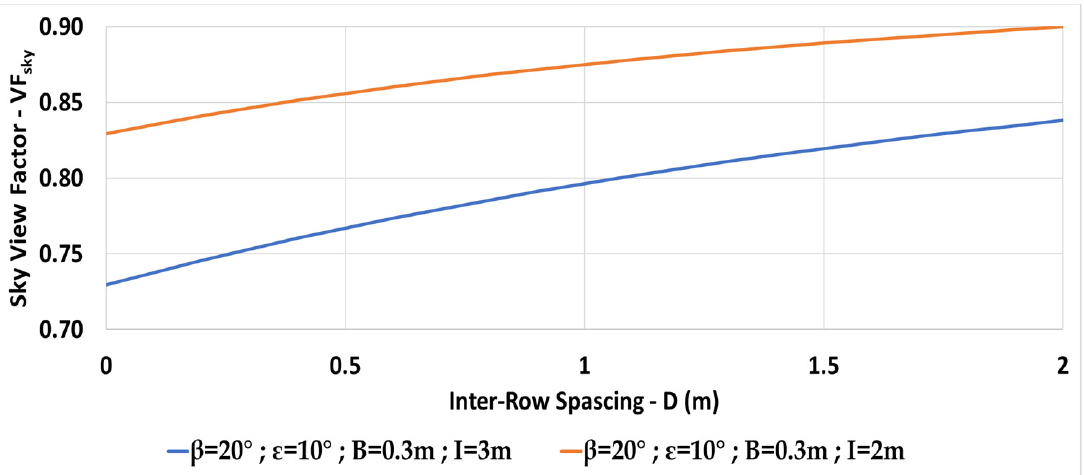
Figure 19. Variation of the sky view factor of collector on an inclined plane with distance from a building of height, 𝐼 .